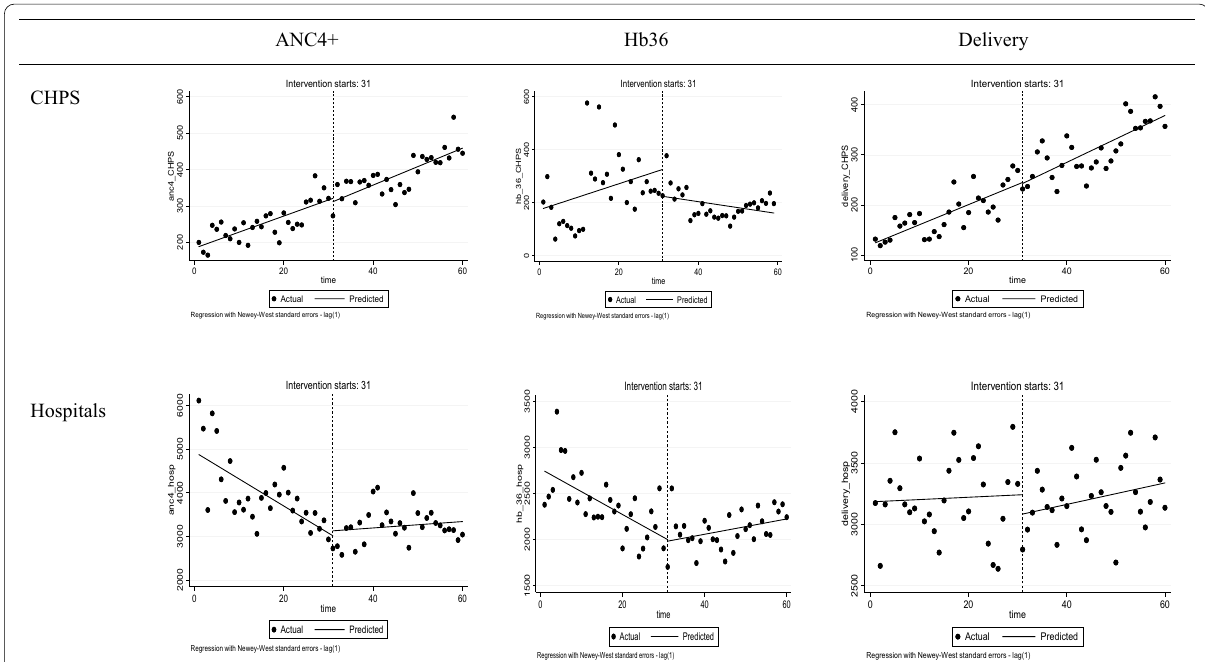
Fig. 1 Interrupted time series graphs for ANC4